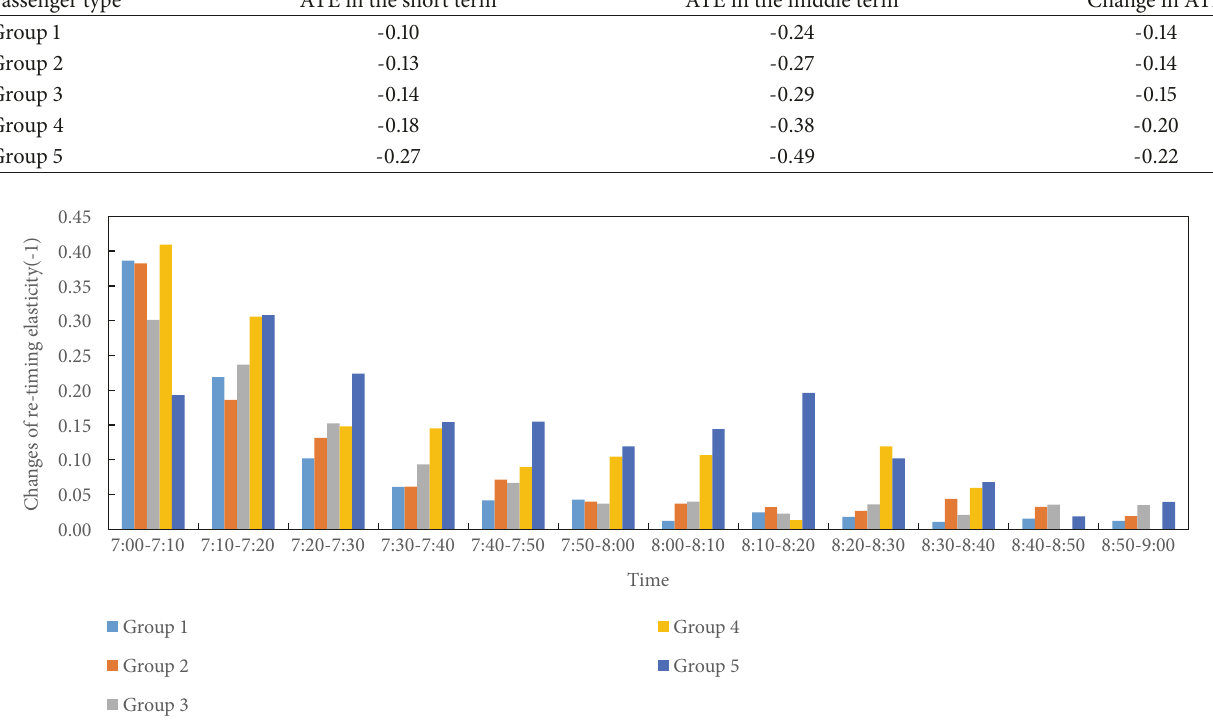
Figure 11: Differences in retiming elasticity between the short term and the middle